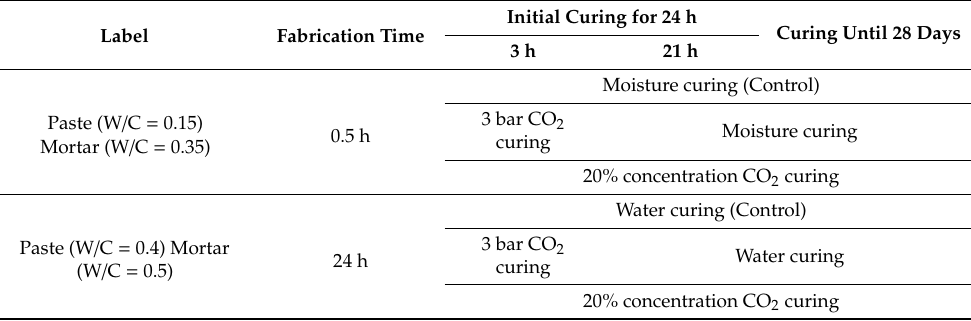
Table 3. Curing condition and sequence for samples.